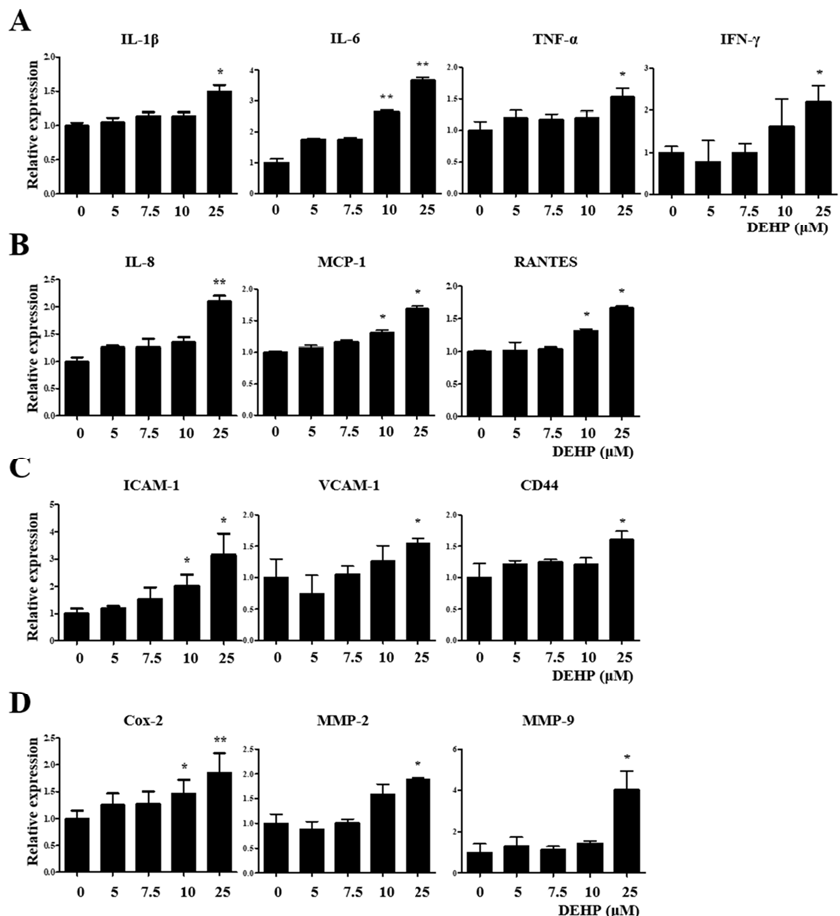
Figure 4. Di-(2-ethylhexyl) phthalate (DEHP) triggers the expression of inflammatory and im- munological mediators in human endometrial epithelial cells, as detected by quantitative reverse transcription-PCR (qRT-PCR). mRNA expression levels of ( A ) proinflammatory cytokines IL-1 β , IL-6 , TNF- α , and IFN- γ ; ( B ) proinflammatory chemokines IL-8 , MCP-1 , and RANTES ; ( C ) cell adhe- sion molecules ICAM-1 , VCAM-1 , and CD44 ; ( D ) COX-2 , MMP-2 , and MMP-9 .